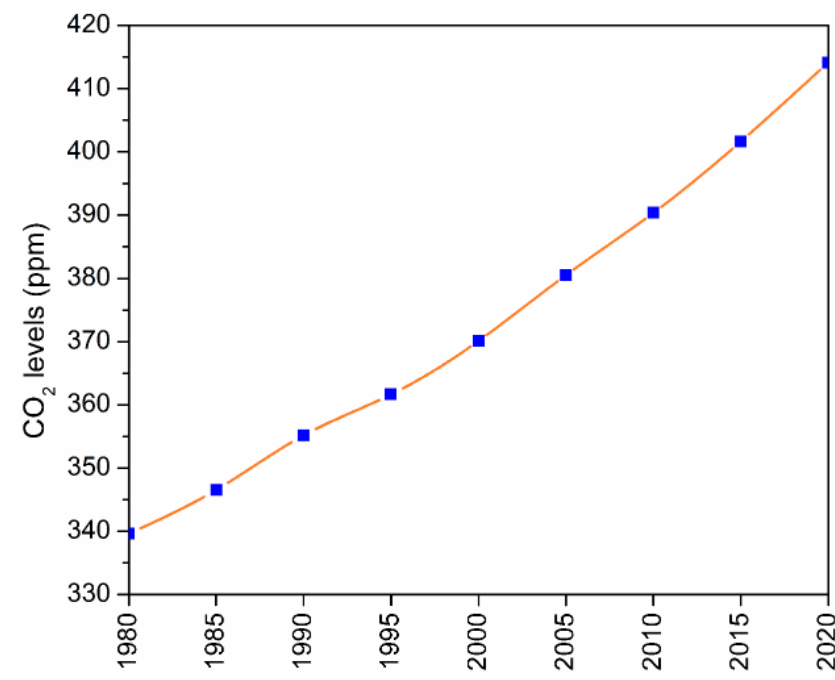
Figure 1. Global atmospheric CO 2 concentrations (Data source: [7]).